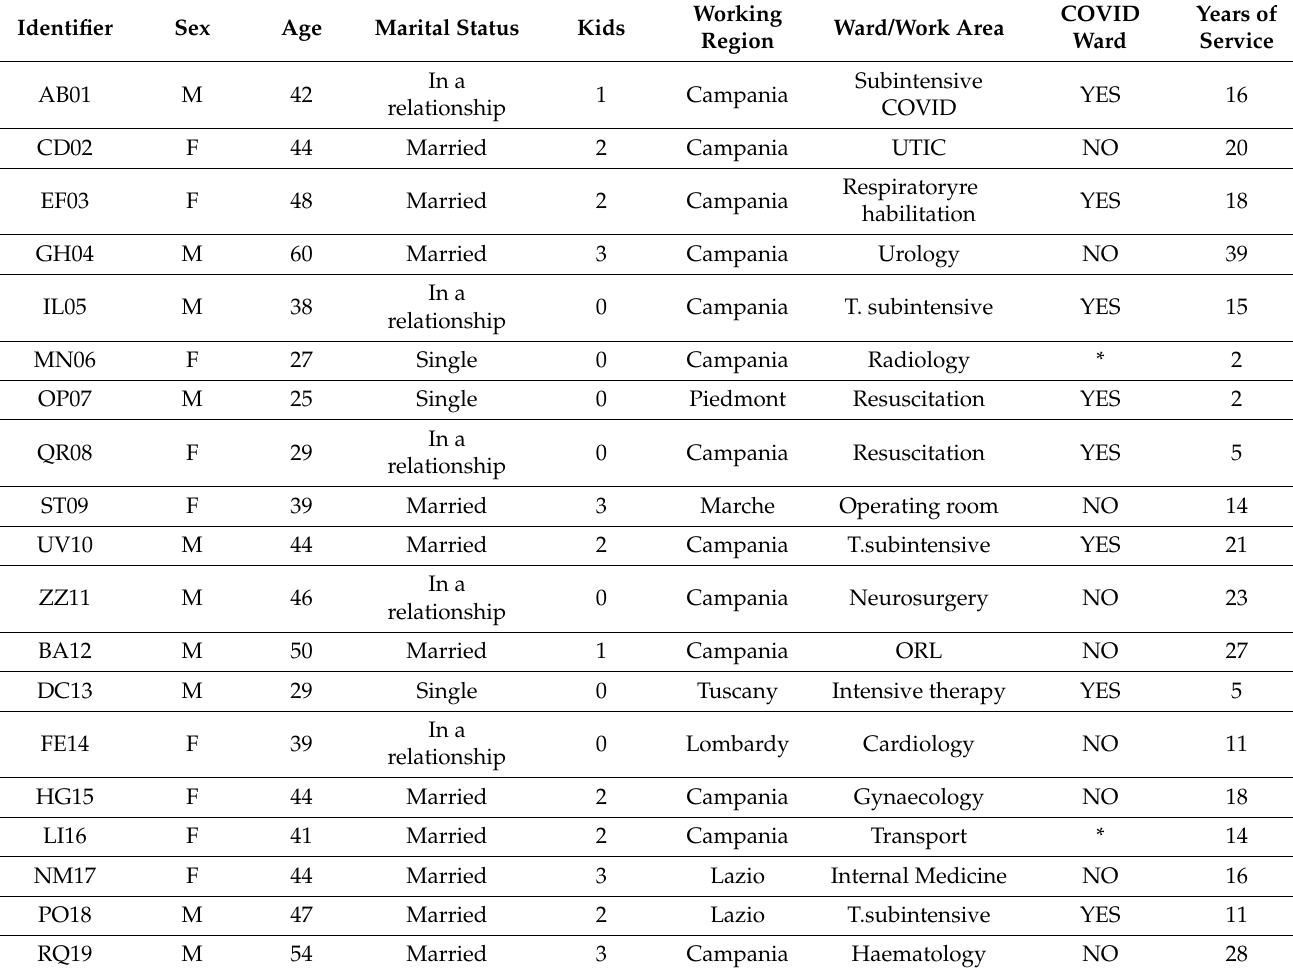
Table 1. Socio-demographic characteristics of nurses (n =